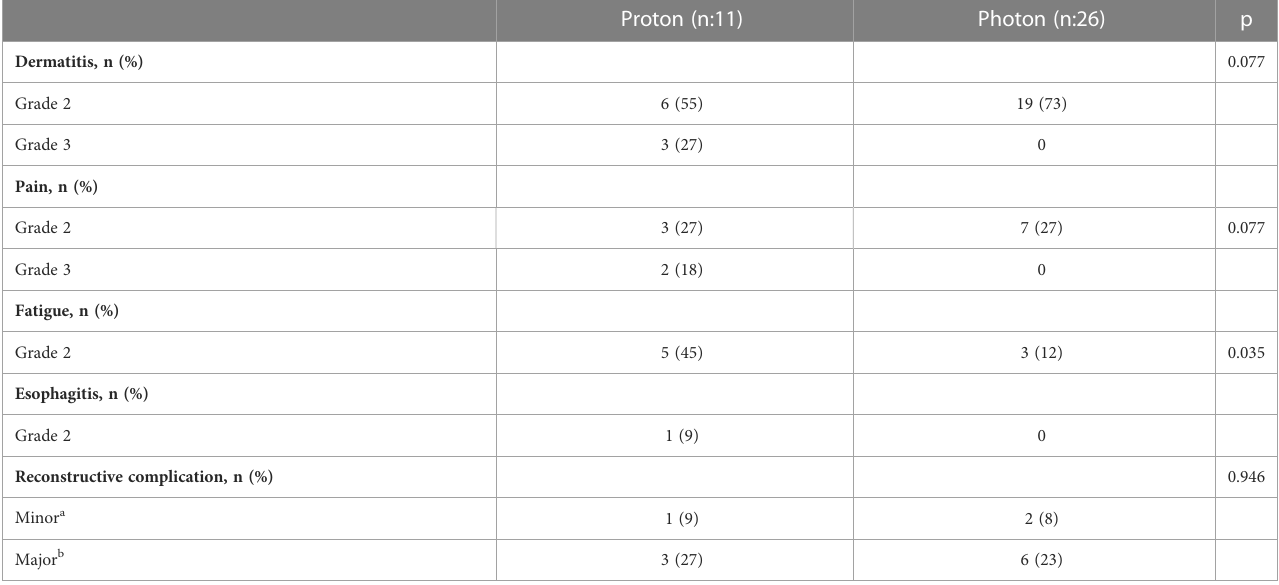
TABLE 3 Treatment related